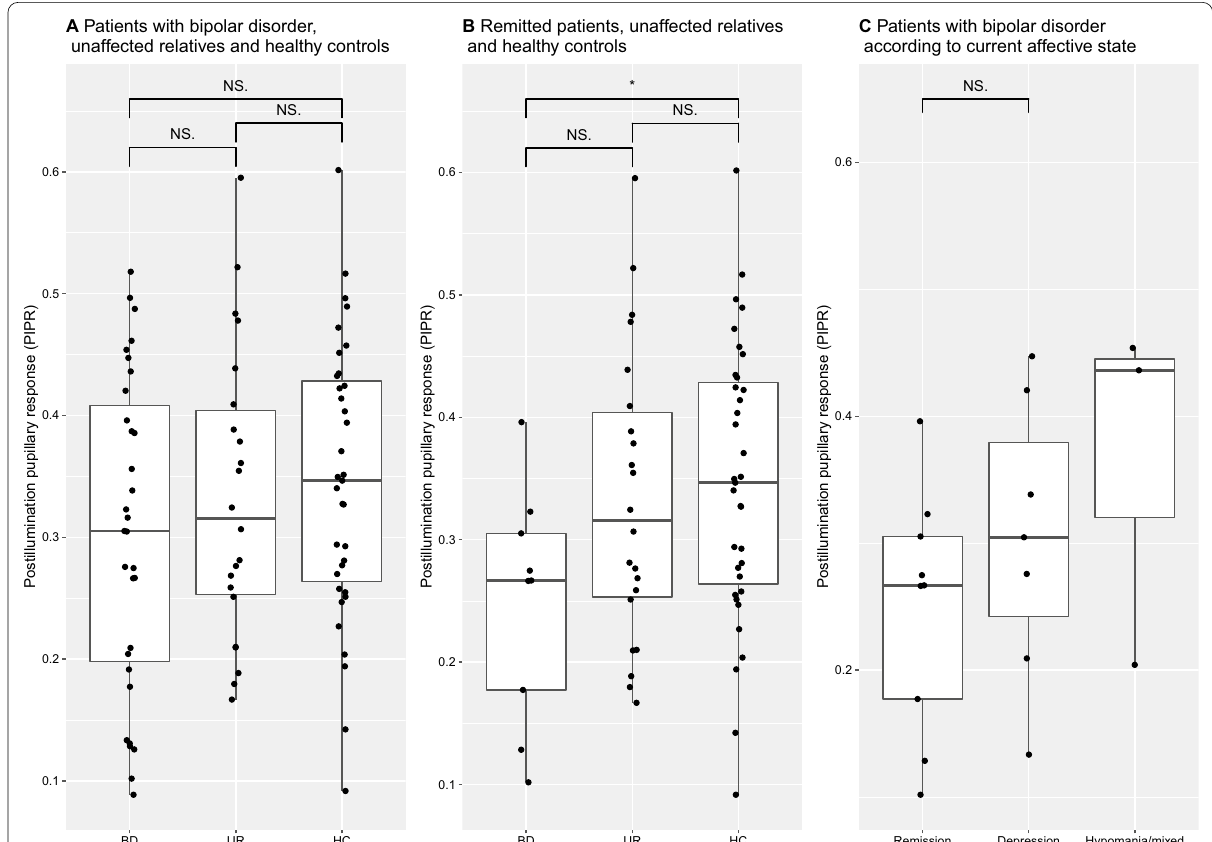
Fig. 1 The post‑illumination pupillary response to blue light (PIPR) according to group and affective state. BD bipolar disorder, UR unaffected relative, HC healthy control individual. NS nonsignificant comparison. Panel A includes 31 persons with BD, 22 UR and 35 HC. Panel B includes hypomanic/mixed state. *denotes a p ‑value <